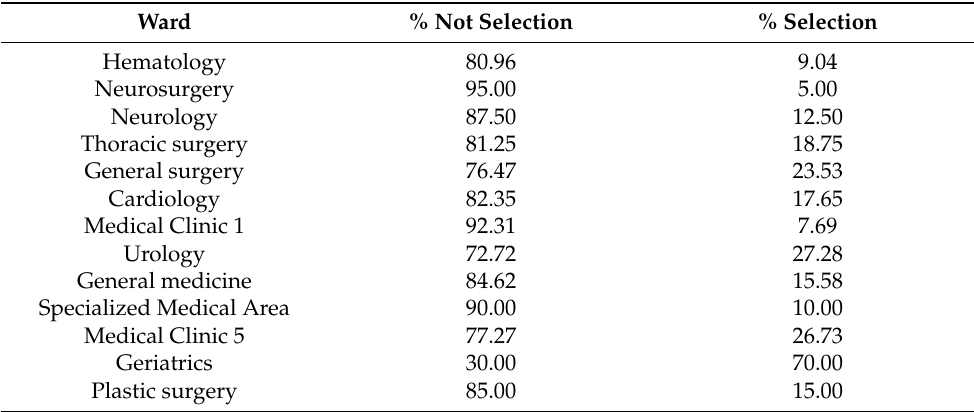
Table 6. Response rate to question 11, with option 11e in the various